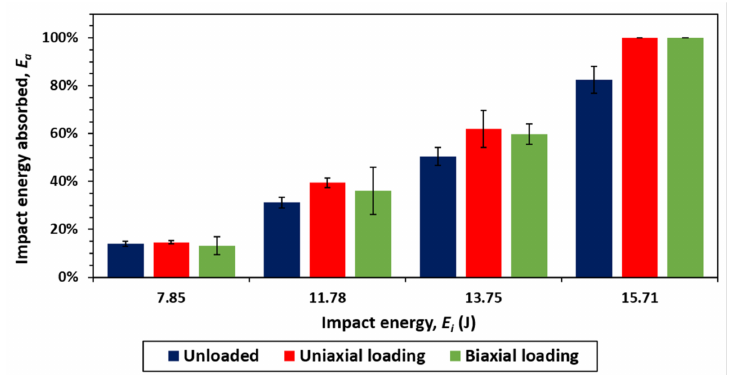
Figure 16. Impact energy absorbed, E a , against impact energy, E i , shown for three different loading conditions: unloaded, uniaxial loading and biaxial